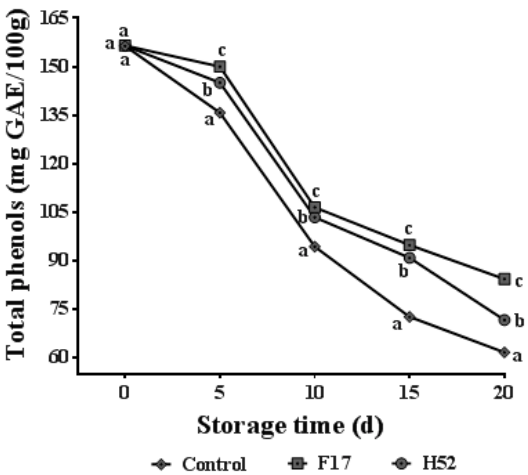
Figure 4. Changes in total phenols of table grapes with treatments during storage at 25 °C. Each point is the average and standard deviation of four replicates. Different lowercase letters at the same storage time indicate a significant difference ( p < 0.05).